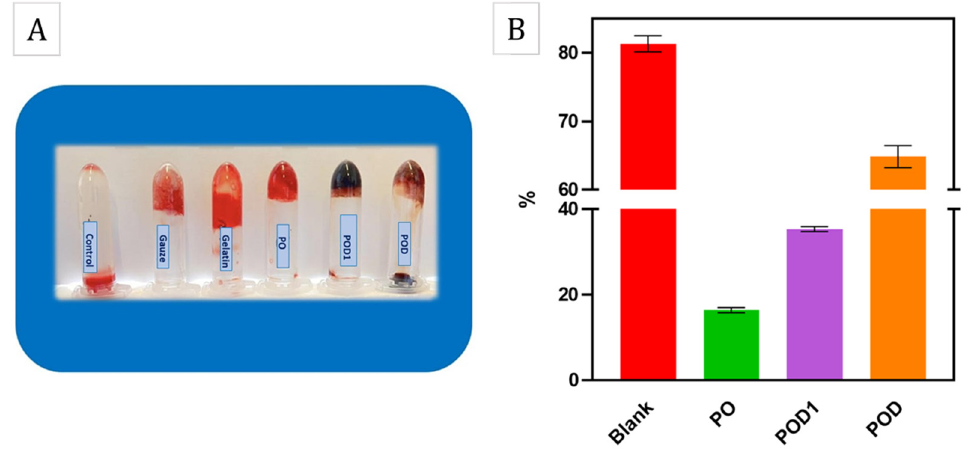
Figure 13. In vitro blood-coagulation results: ( A ) blood-coagulation photographs of control, medical gauze, gelatin and cryogel samples; ( B ) BCI values of the cryogel samples incubated in whole blood for 10 min.